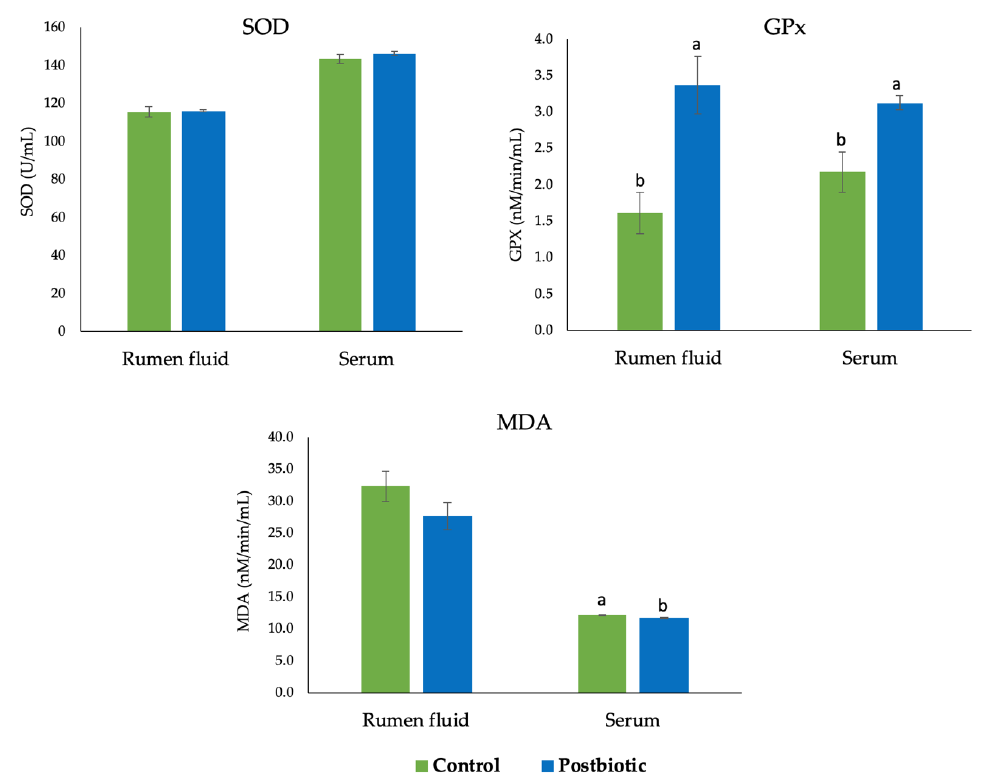
Figure 1. Serum antioxidant activity in post-weaning lambs supplemented with postbiotics from L. plantarum RG14. SOD: Superoxide dismutase, GPX: Glutathione peroxidase, MDA: Malondialdehyde. a,b Bar with di ff erent letters between treatment groups are significantly di ff erent ( p < 0.05).